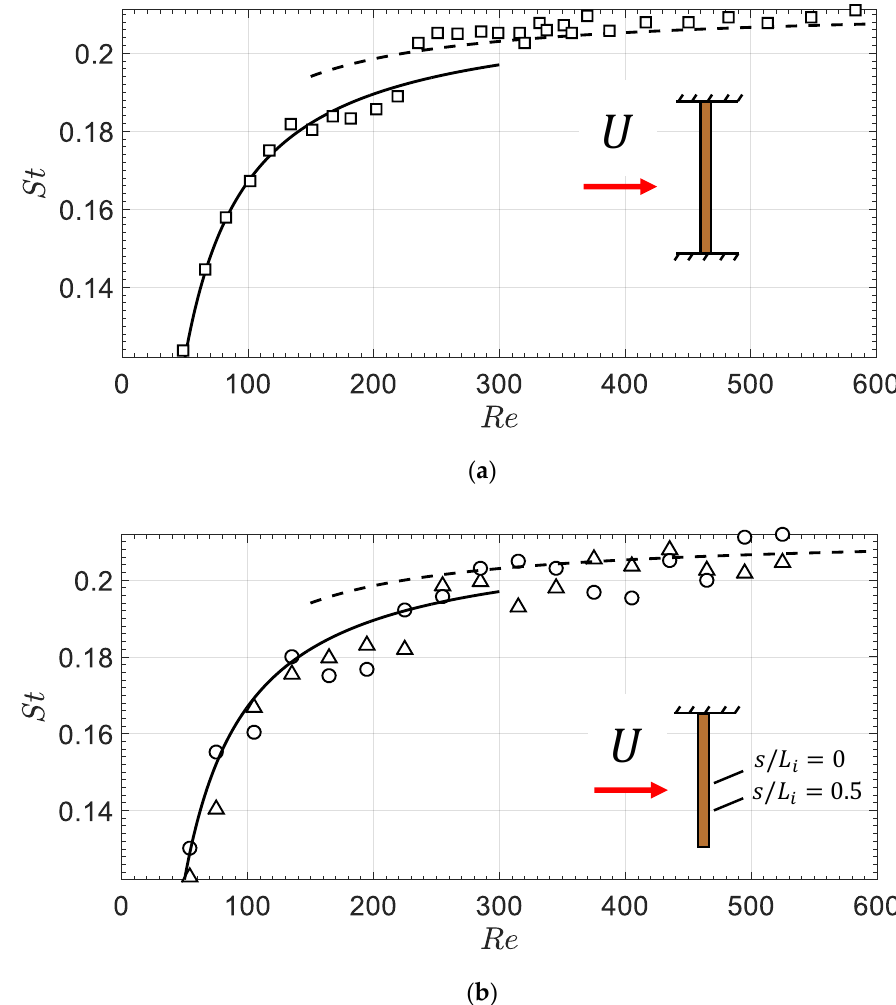
Figure 5. Experimental setup validation: Strouhal number versus Reynolds number for the smooth circular cylinder in cross-flow: fixed-fixed cylinder ( a ), and bent cylinder in its asymptotic limiting configuration at 90° yaw angle ( b ). Symbols: 𝑠/𝐿 𝑖 = 0 (△), 0.5(○) . Continuous line: Equation (3); Dashed line: Equation (4).